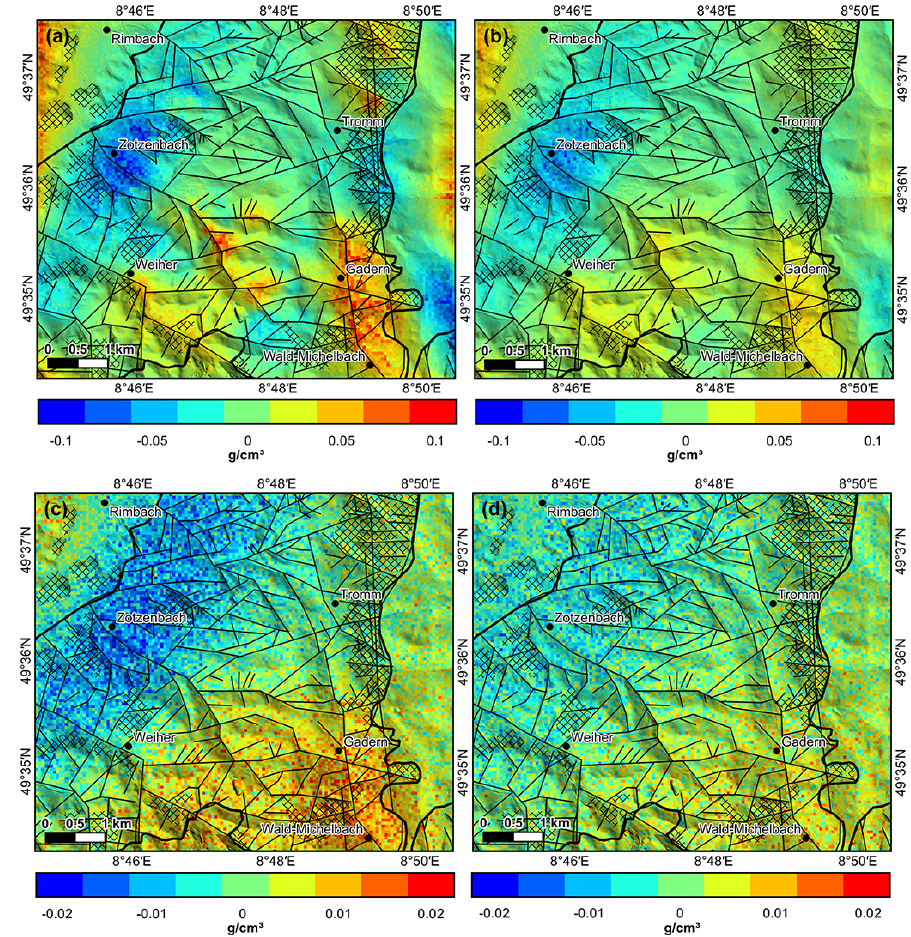
Figure 10. Results of the gravity inversion. Difference between the inverted density and the initial density of 2670 ± 50kgm − 3 at (a) the top of the basement, (b) 0ma.s.l., (c) 1000mb.s.l. and (d) 2000mb.s.l. Note the different color scales for (a) and (b) vs. (c) and (d)